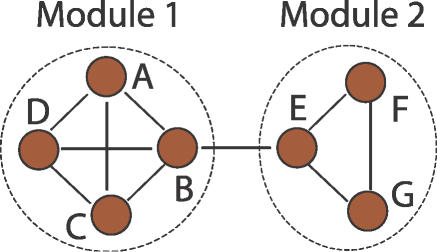
Topology-Based Network AnalysisDensely connected subgraphs can be identified from interaction networks, suggesting the existence of multi-component complexes.